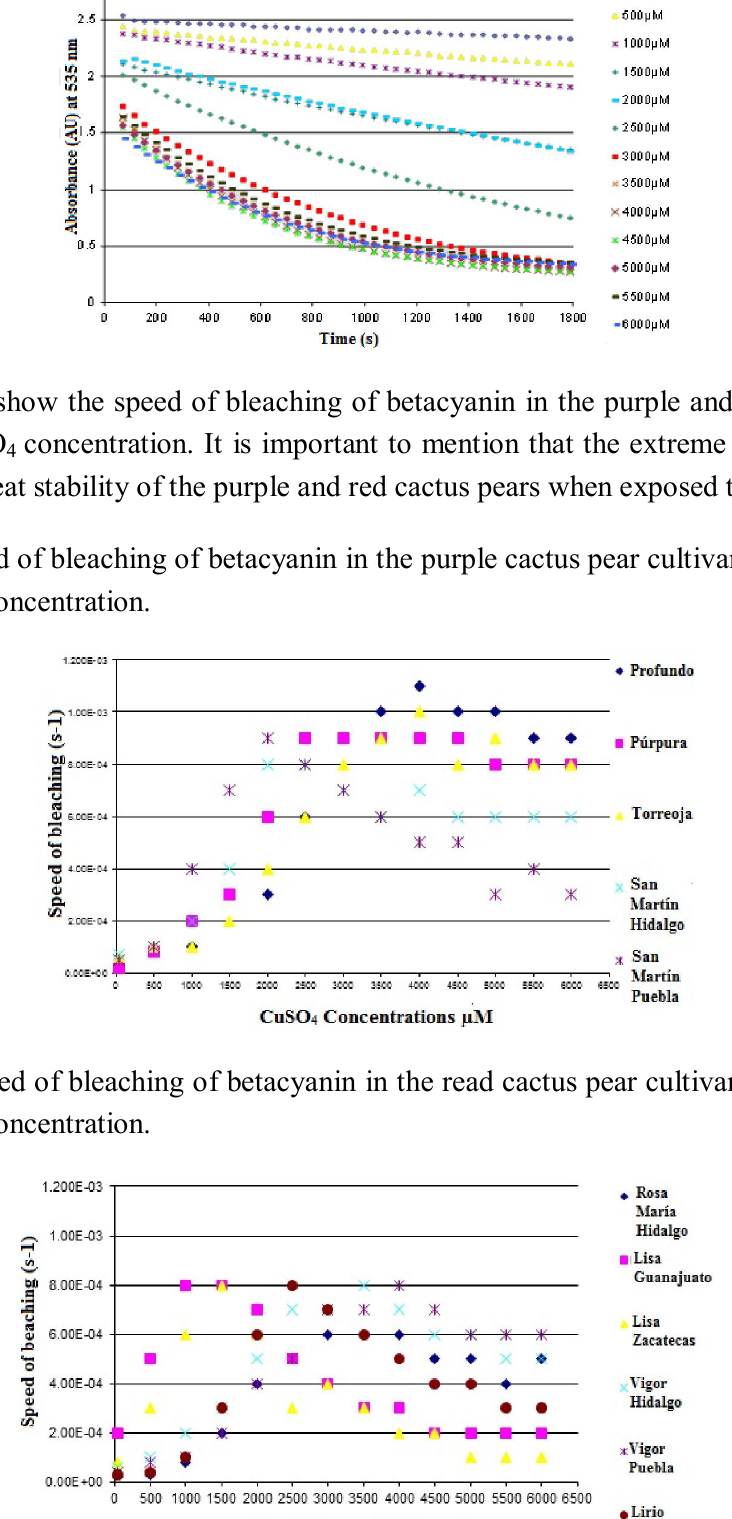
Figure 8. Kinetic curves for the speed of bleaching of betacyanin in the purple cactus pear Profundo from Hidalgo, based on the concentration of CuSO